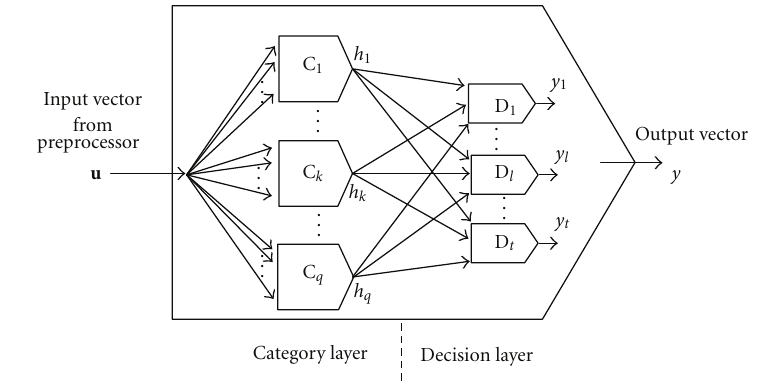
Figure 5: Neural decision processor (NDP) for a group decision making process. This NDP is composed of a category layer and a decision